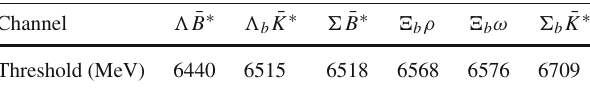
Table5 Beautysectorchannelswith J P = 1 / 2 − , 3 / 2 − andrespective thresholds Channel